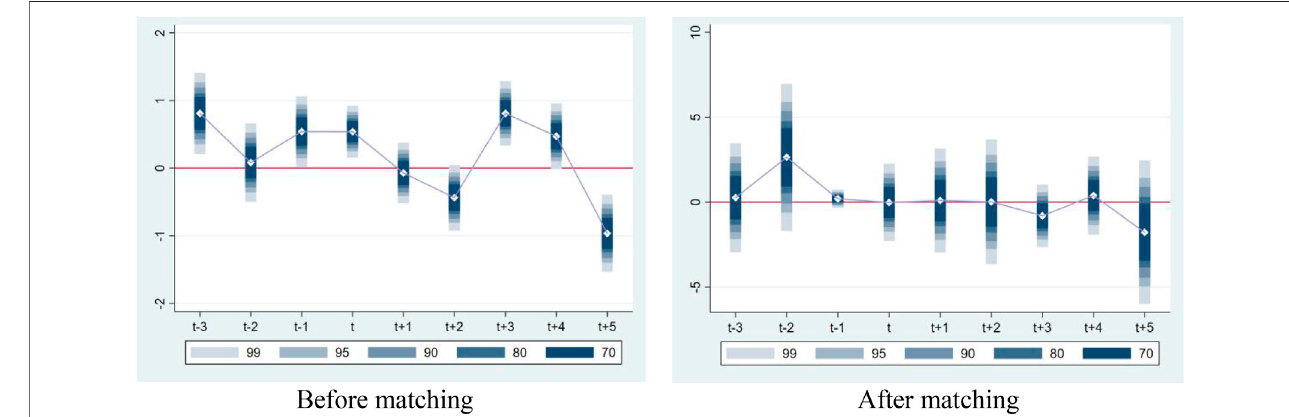
FIGURE 3 | Parallel trends before and after PSM.